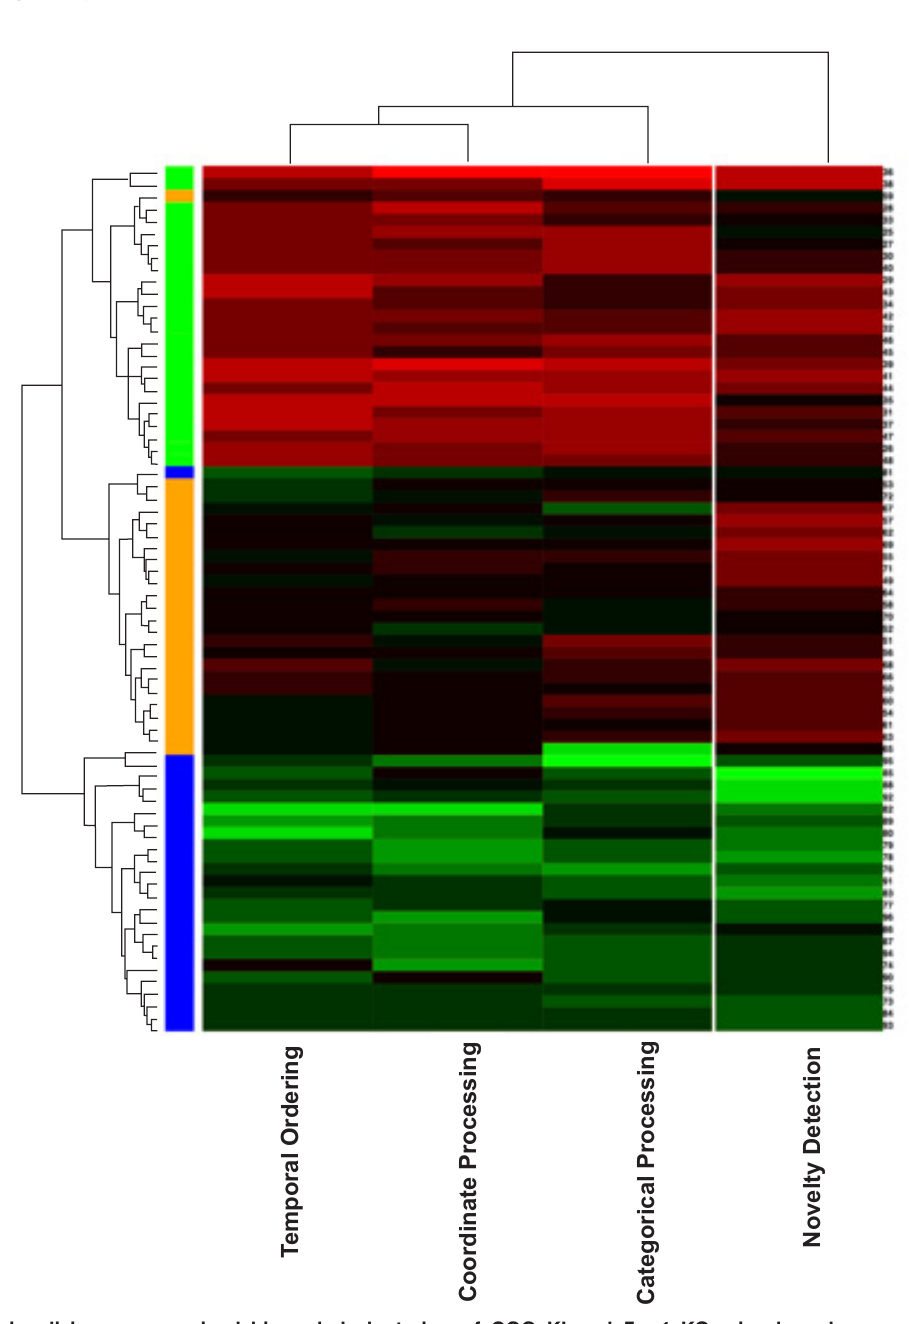
Figure 7. Heatmap visualizing unsupervised hierarchal clustering of CGG KI and Fmr1 KO mice based on overall behavioral performance. Note how the algorithm was capable of separating groups with high levels of accuracy with only a single Fmr1 KO mouse and one High CGG KI mouse being misclassified. The colors along the right hand column of the heatmap correspond to the group colors used in Figure